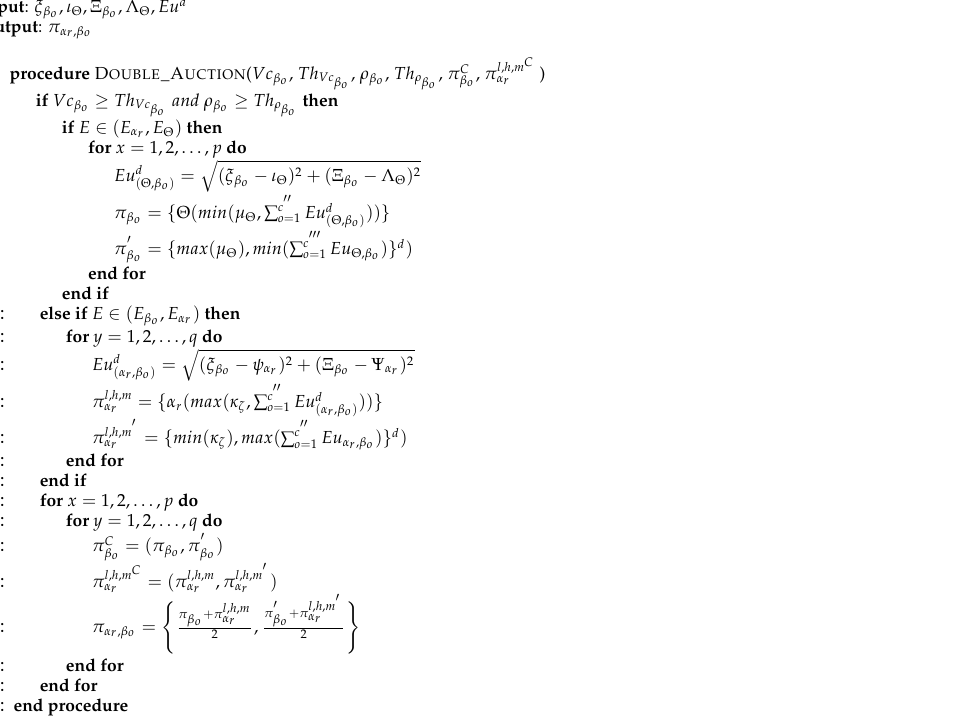
Algorithm 2 The truthful double auction mechanism between EVs for optimal